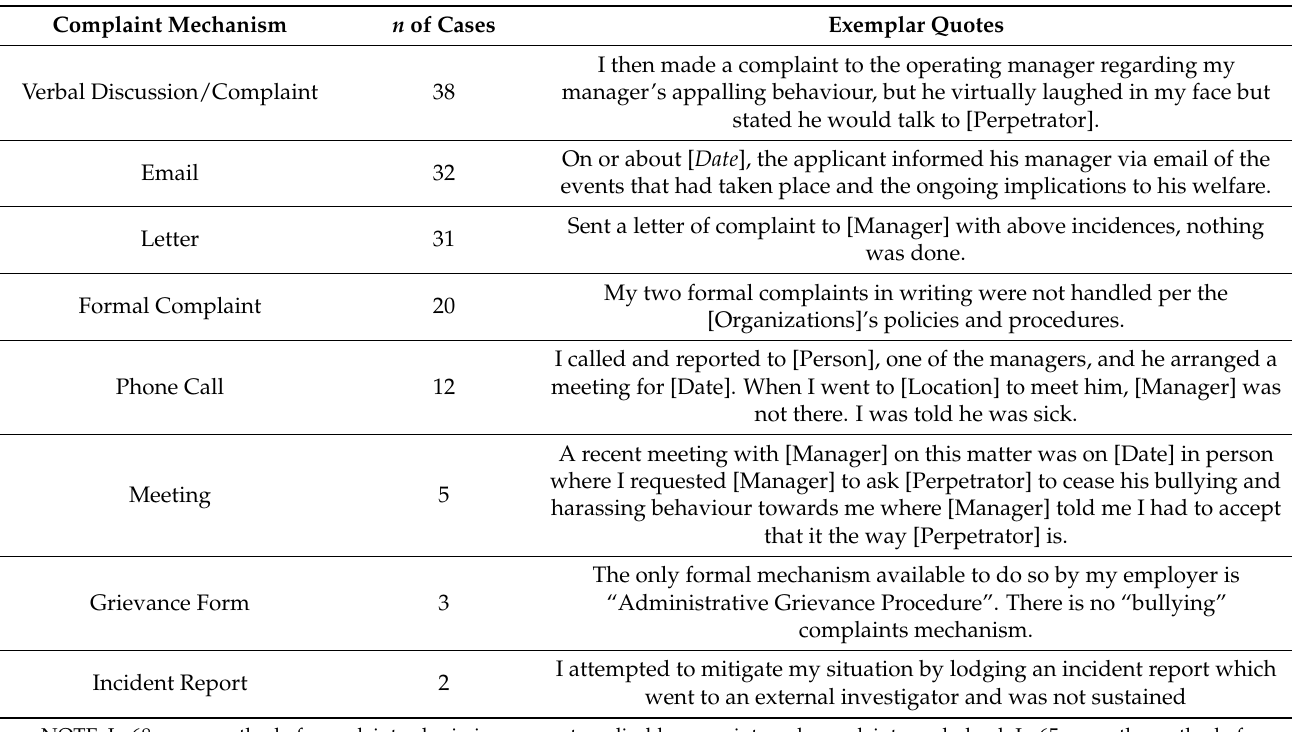
Table 4. Method of Submitting Complaint Internally.